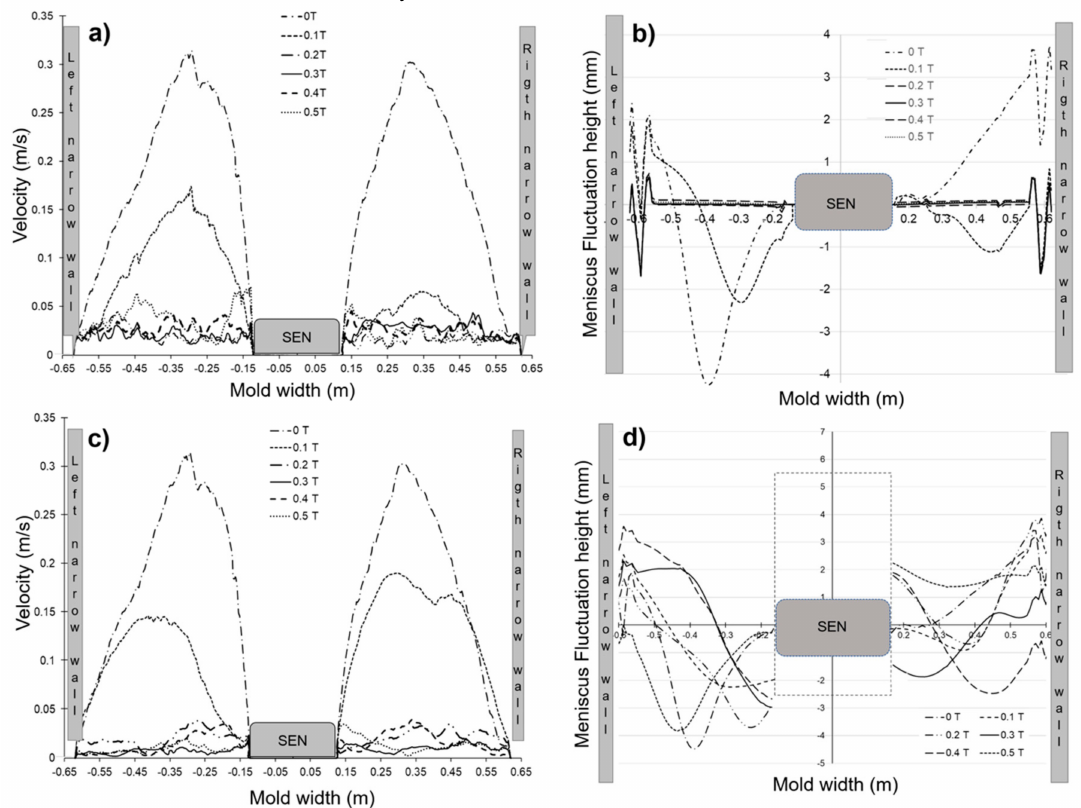
Figure 8. Meniscus velocity and meniscus fluctuation during steady-state conditions considering both EMBr types, ( a , b ) H-EMBr and ( c , d )